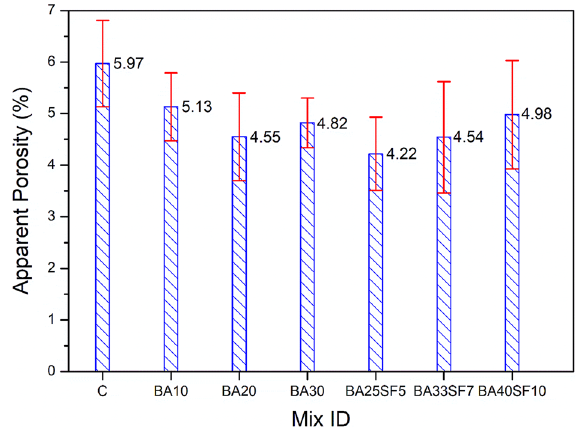
Figure 7. Comparison of apparent porosity results between control and other concrete samples of binary and ternary mixes after 91 days of standard